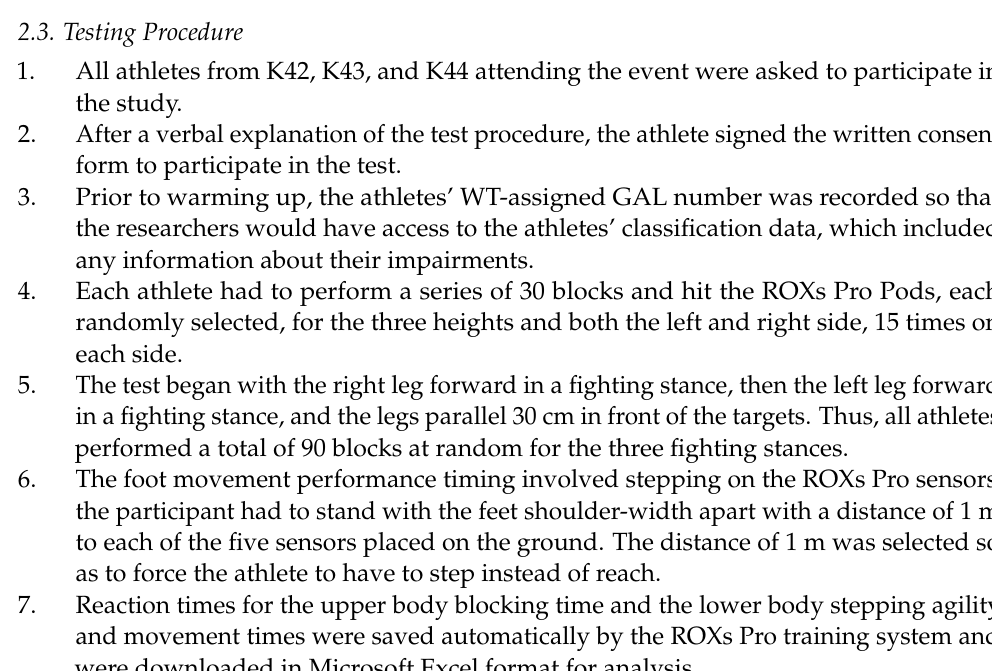
Figure 3. Overview of taekwondo stepping reaction test